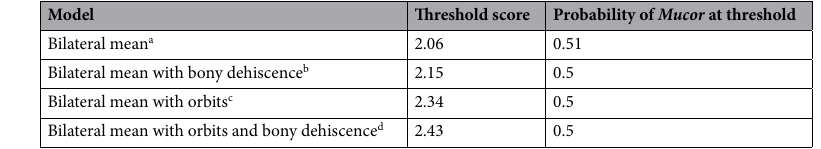
Table 3. Cutoffs for scores for predicting Aspergillus versus Mucor in various combinations of the bilateral mean model. a Model included nasal cavity, maxillary sinus, ethmoid air cells, sphenoid sinus and frontal sinus. b Model included nasal cavity, maxillary sinus, ethmoid air cells, sphenoid sinus, frontal sinus and bony dehiscence. c Model included nasal cavity, maxillary sinus, ethmoid air cells, sphenoid sinus, frontal sinus and orbital involvement. d Model included nasal cavity, maxillary sinus, ethmoid air cells, sphenoid sinus, frontal sinus, bony dehiscence and orbital